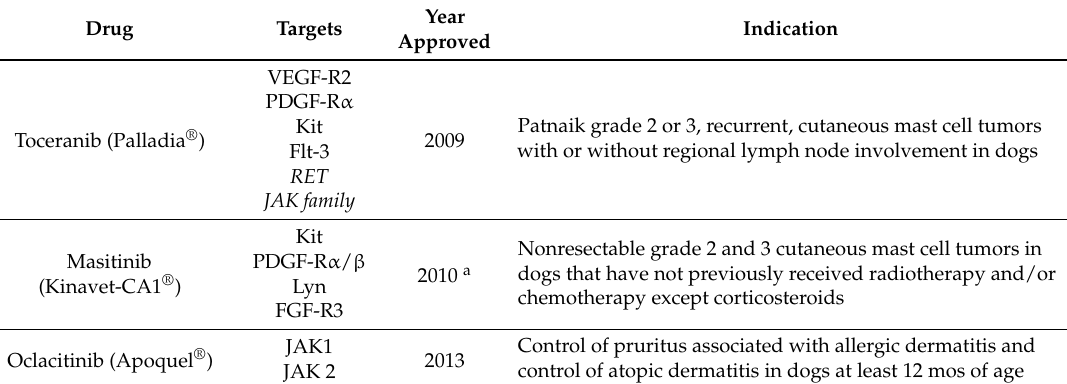
Table 2. Approved tyrosine kinase inhibitors in veterinary medicine, all drugs.